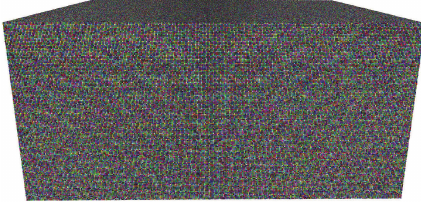
Figure 4: The basic